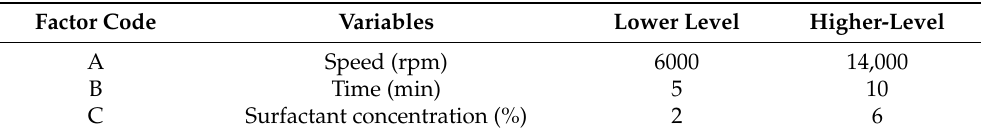
Table 1. Independent variables and their